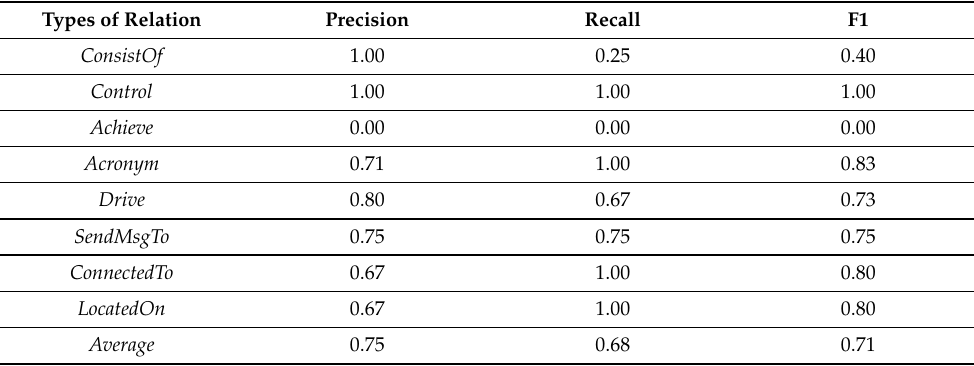
Table 8. One-stage method: relation extraction results based on annotated entities.